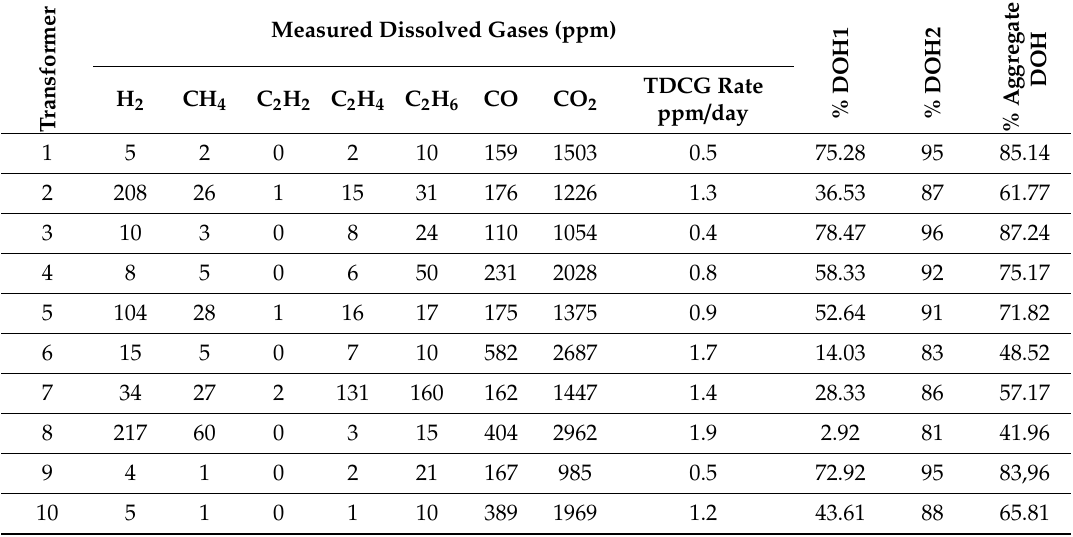
Table 4. Typical transformers with degree of healthiness (DOH) calculated. TDCG: Total Dissolved Combustible